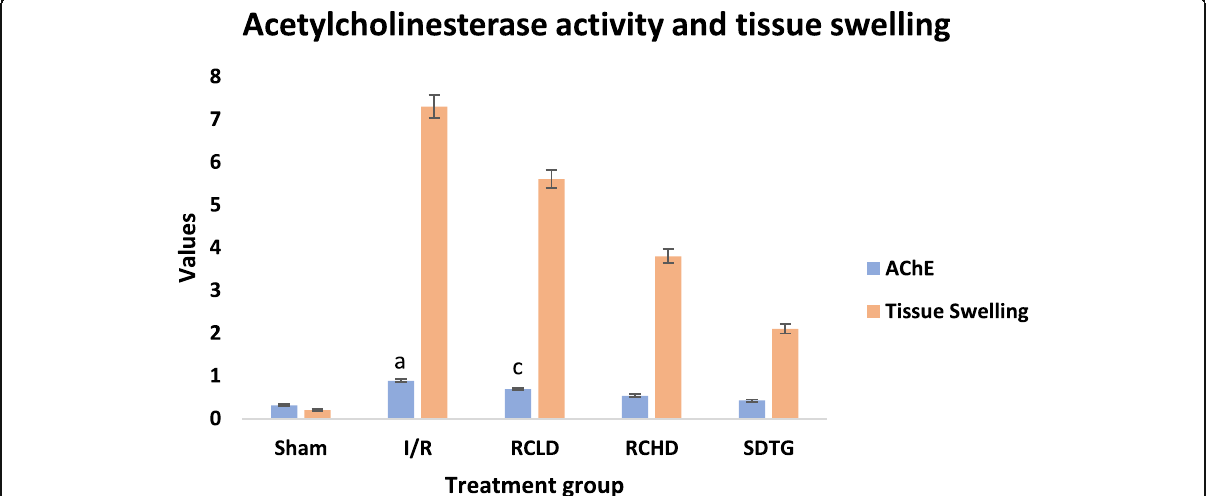
Fig. 5 Acetylcholinesterase (AChE) activity in the different treatment groups. Where, values are indicated as mean ± SEM; ( n = 5) in each group. Data were subjected to one-way ANOVA followed by Dunnett ’ s test when RCLD, RCHD, and SDTG groups were compared to the I/R group, while the I/R group was compared to the Sham group. a p < 0.01, when compared to Sham Group, c p < 0.01, d p < 0.001, when compared to I/R group.